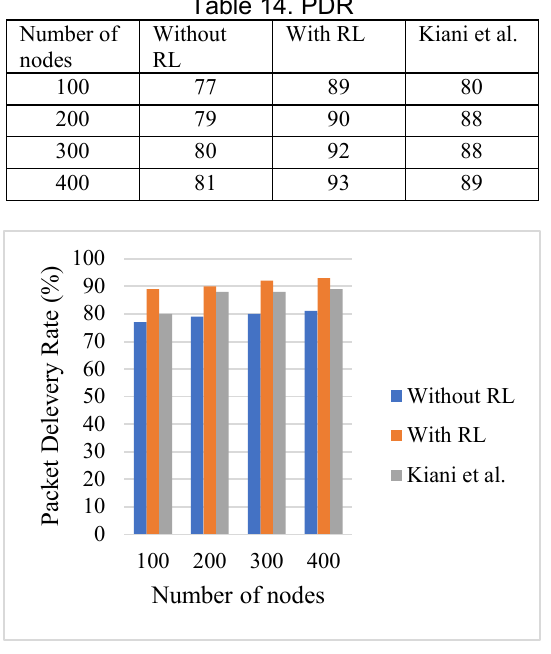
Figure 16. Packet Delivery Rate